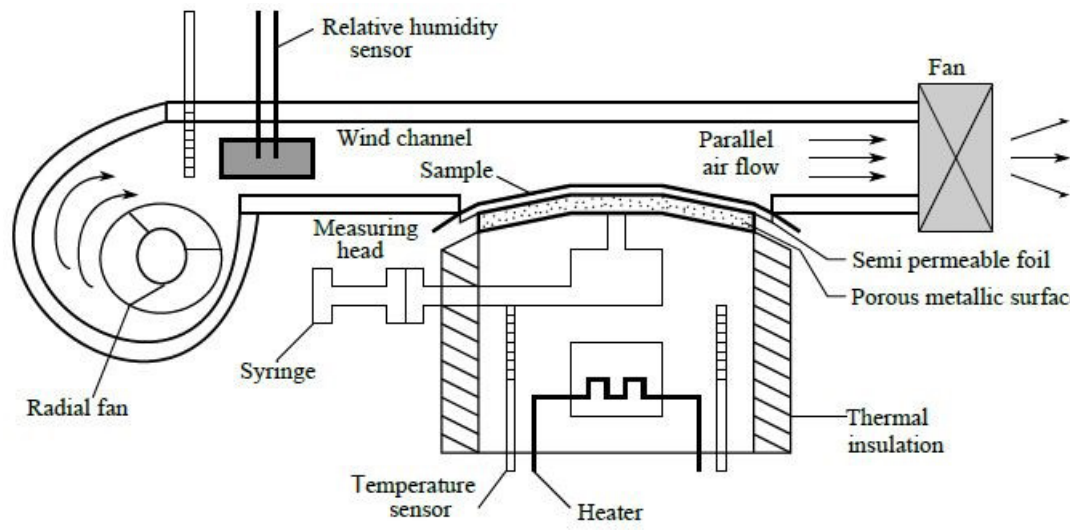
Figure 1. The working principle of Permetest, adapted from 30